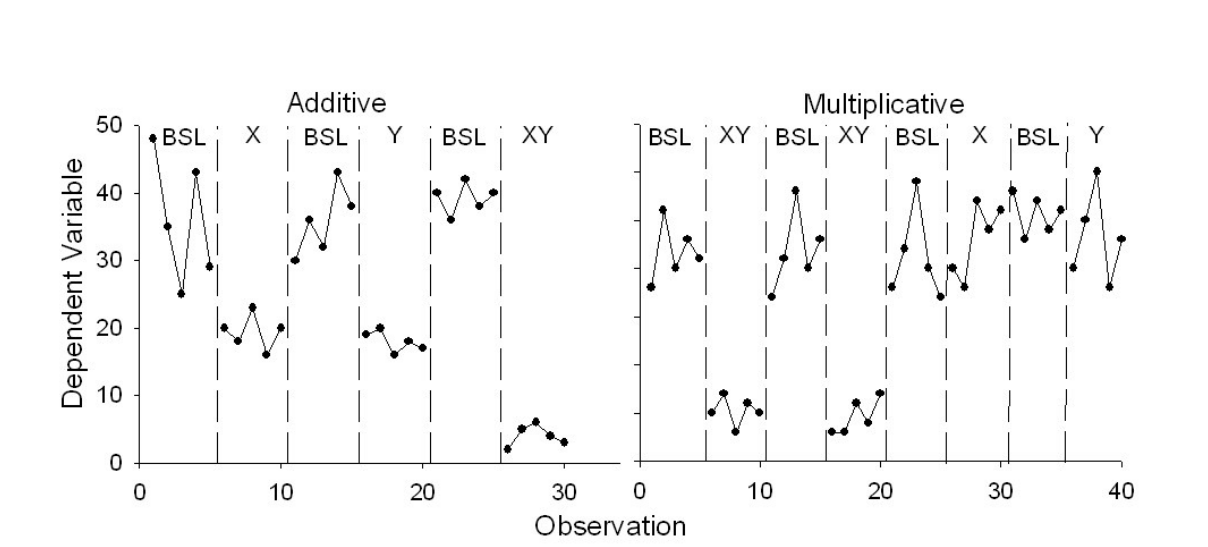
Figure 4. Two examples of possible results from a component analysis (BSL=baseline, X=first component, Y=second